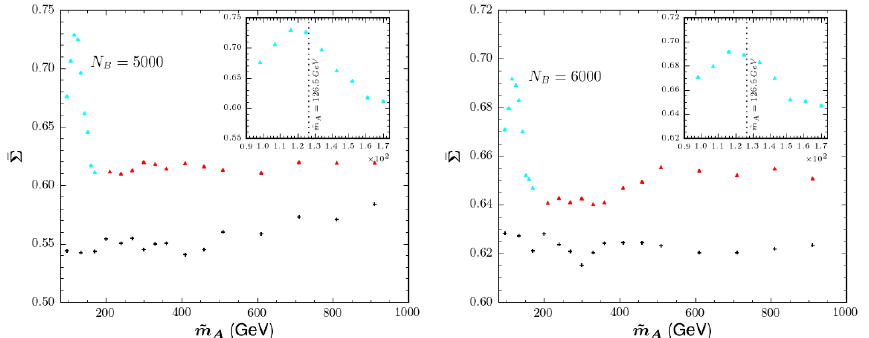
Figure 29 . The same as the lower two plots in (cid:12)gure 25, but for signal events where particles D are pair-produced and one of them decays as in (cid:12)gure 1, while the other decays to 3 jets and particle